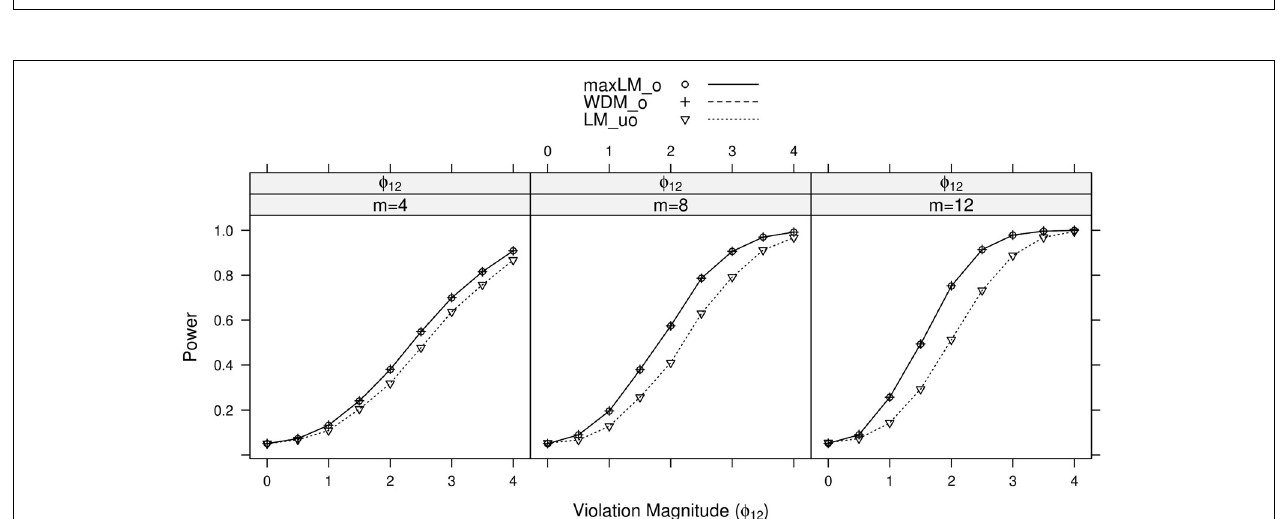
The parameter violating measurement invariance is λ 11 . Panel labels denote the parameter(s) being tested and the number of levels of the ordinal √ n ), Simulation 1. variable m .